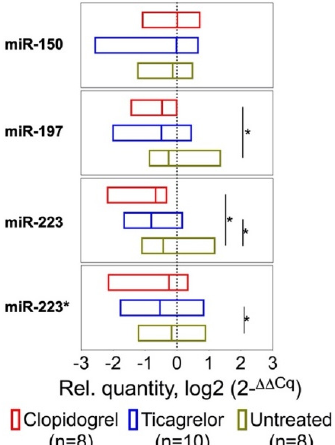
Figure 1. Circulating miRNA levels after antiplatelet therapy. Levels of platelet-enriched miR-197, miR-223 and miR-223* were significantly lower after one week of treatment with either ticagrelor or clopidogrel, compared with the untreated control group. Leukocyte-enriched miR-150 was not affected. Bars and lines represent range and median. Wilcoxon’s signed-rank test was used for statistical comparison. * denotes p-value < 0.05.